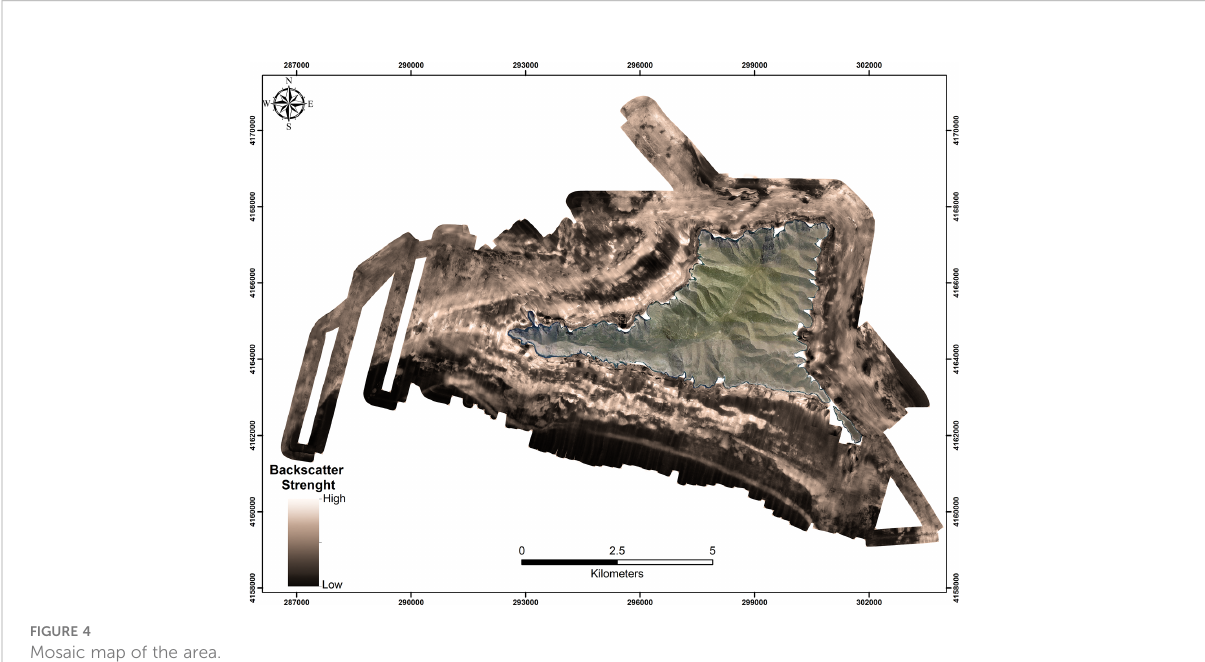
FIGURE 4 Mosaic map of the